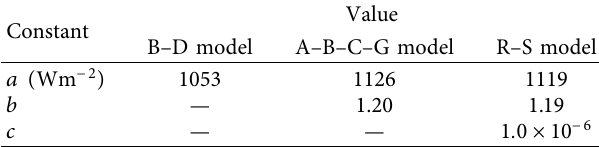
Table 1: Extracted empirical constants for the three models. Constant